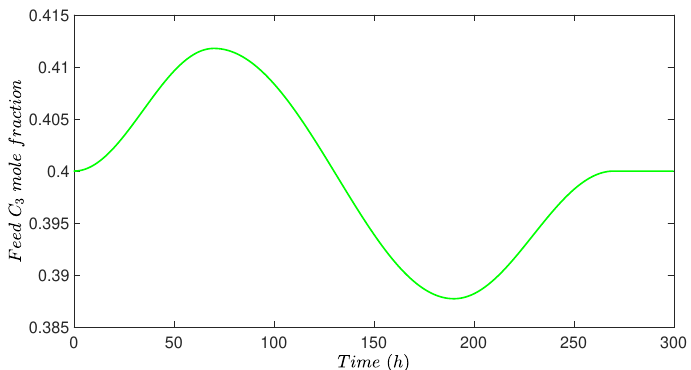
Figure 13. The feed concentration profile of the distillation column, which is changing with respect to